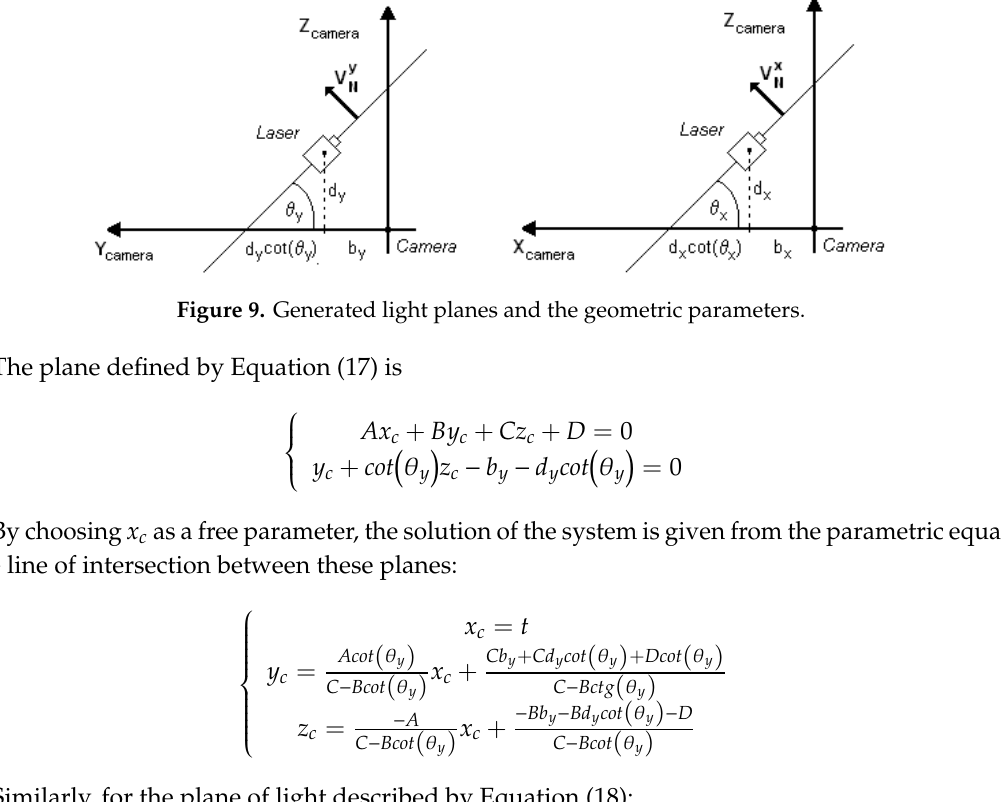
7 of 20 Figure 8. Geometric parameters of the digitization system. A point P on the object reference system with coordinates ( x w , y w , z w ) has its coordinates expressed in the camera coordinate system ( x c , y c , z c ) by the following equation: (cid:3429)𝑥 (cid:3030) 𝑦 (cid:3030) 𝑧 (cid:3030) (cid:3433) = 𝑅. (cid:3429)𝑥 (cid:3050) 𝑦 (cid:3050) 𝑧 (cid:3050) (cid:3433) + 𝑇 , (12) where R is an orthonormal rotation matrix 3 × 3 and T is a translation vector representing the spatial coordinates of the origin of the world reference system expressed in the camera coordinate system. Considering that R and T , defined in Equation (12), perform the transformation of the world reference system to the camera reference system, it is possible to determine the equation of the reference plane in relation to the camera from the transformation below: 0𝑥 (cid:3050) + 0𝑦 (cid:3050) + 1𝑧 (cid:3050) + 0 = 0𝑅, 𝑇 → 𝐴𝑥 (cid:3030) + 𝐵𝑦 (cid:3030) + 𝐶𝑧 (cid:3030) + 𝐷 = 0 ,